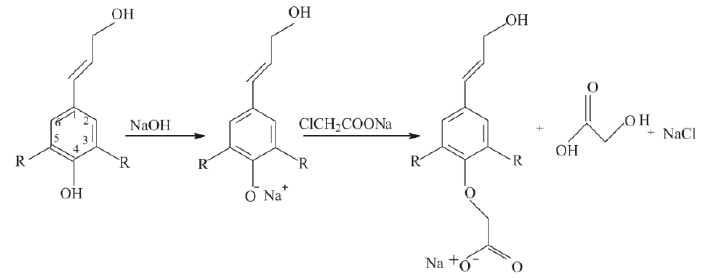
Figure 10. Carboxymethylation of lignin reaction scheme. ‘‘R’’ can be OCH 3 or H [93].